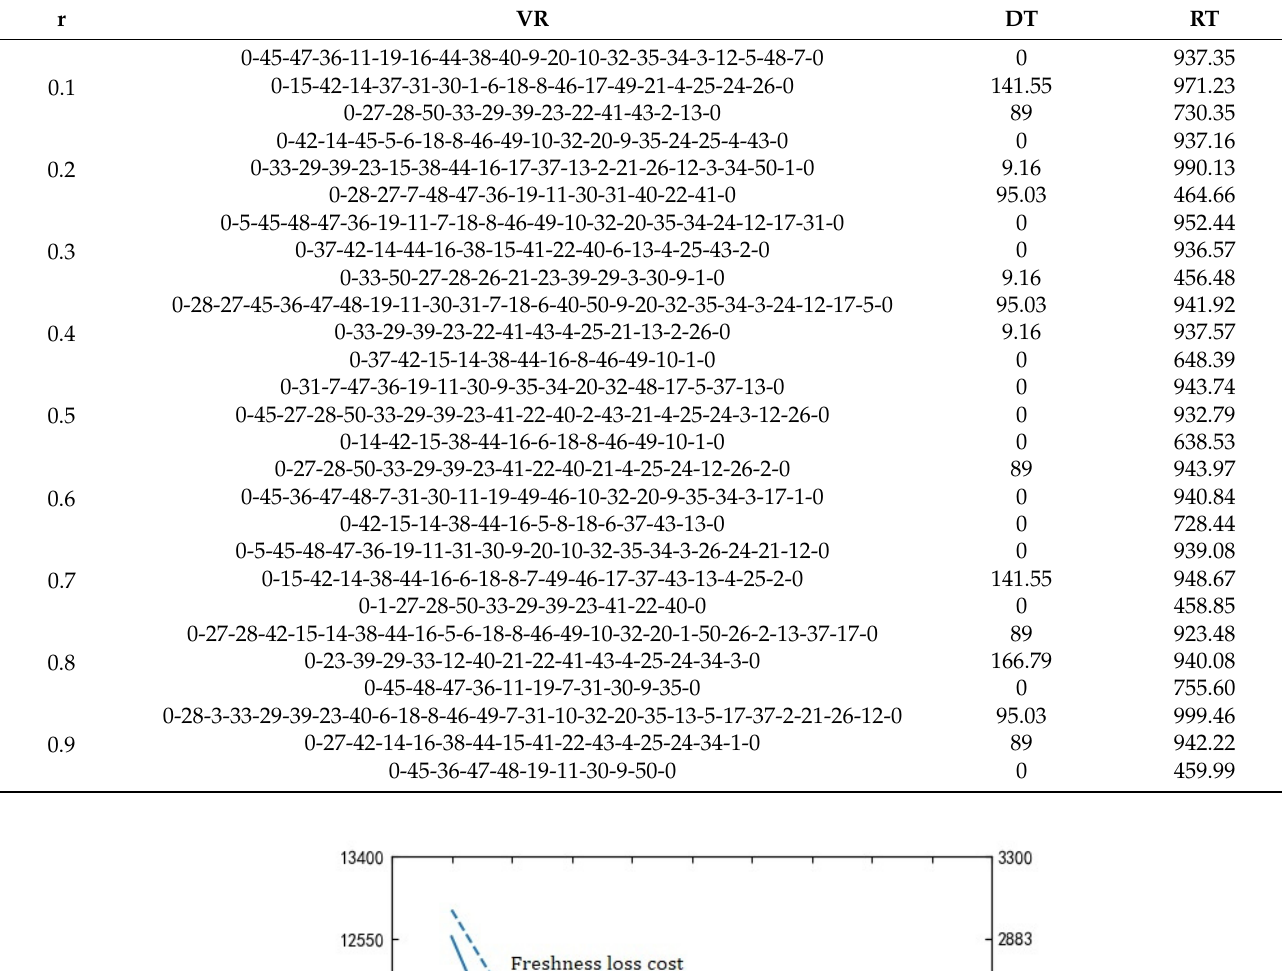
Table 5. The influence of different regulatory factors on the distribution plan.